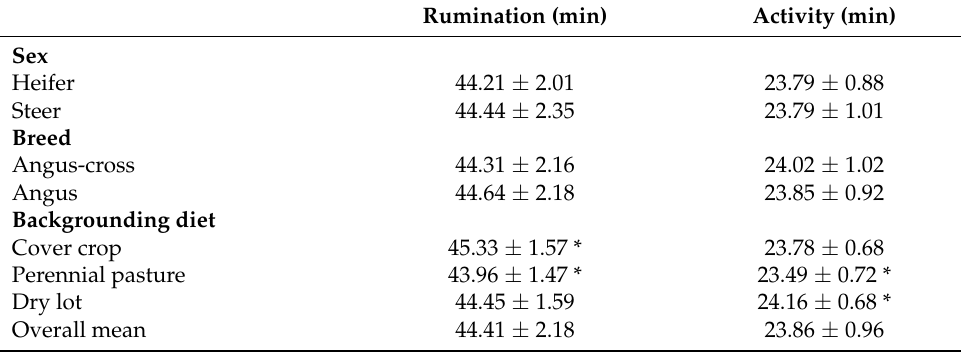
Table 2. Effects of sex, breed, and backgrounding on rumination and activity in beef